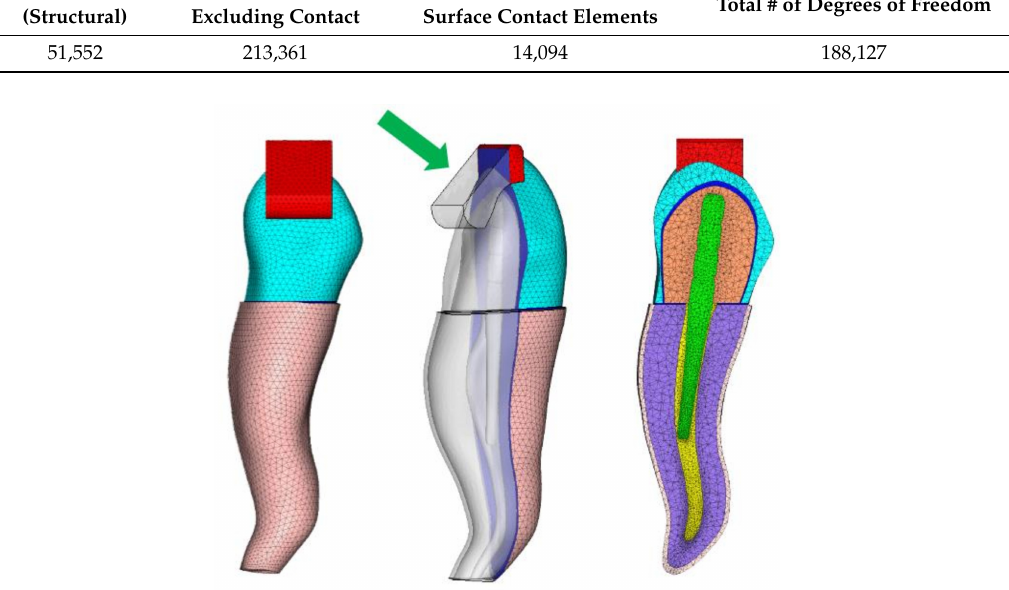
Figure 1. Models A1 and A2: Theoretical model according to the different components, mechanical properties, and technical and geometric